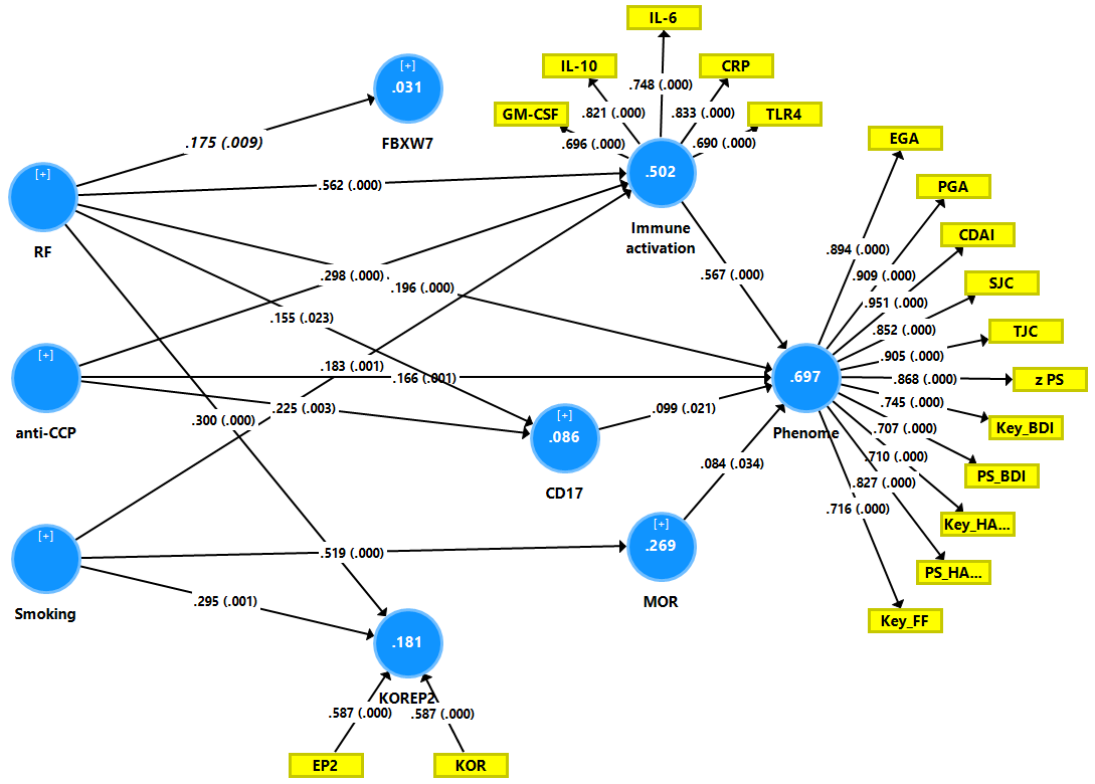
Figure 4. Results of Partial Least Squares (PLS) path analysis. TJC: tender joint count, SJC: swollen joint count, PGA: patient global assessment,